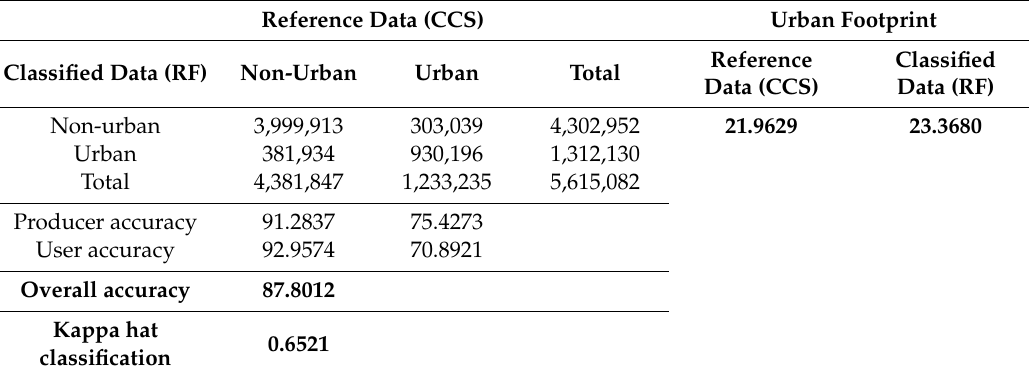
Table 4. Error matrix related to RF classification performed on the multitemporal coherence image in the Venice study